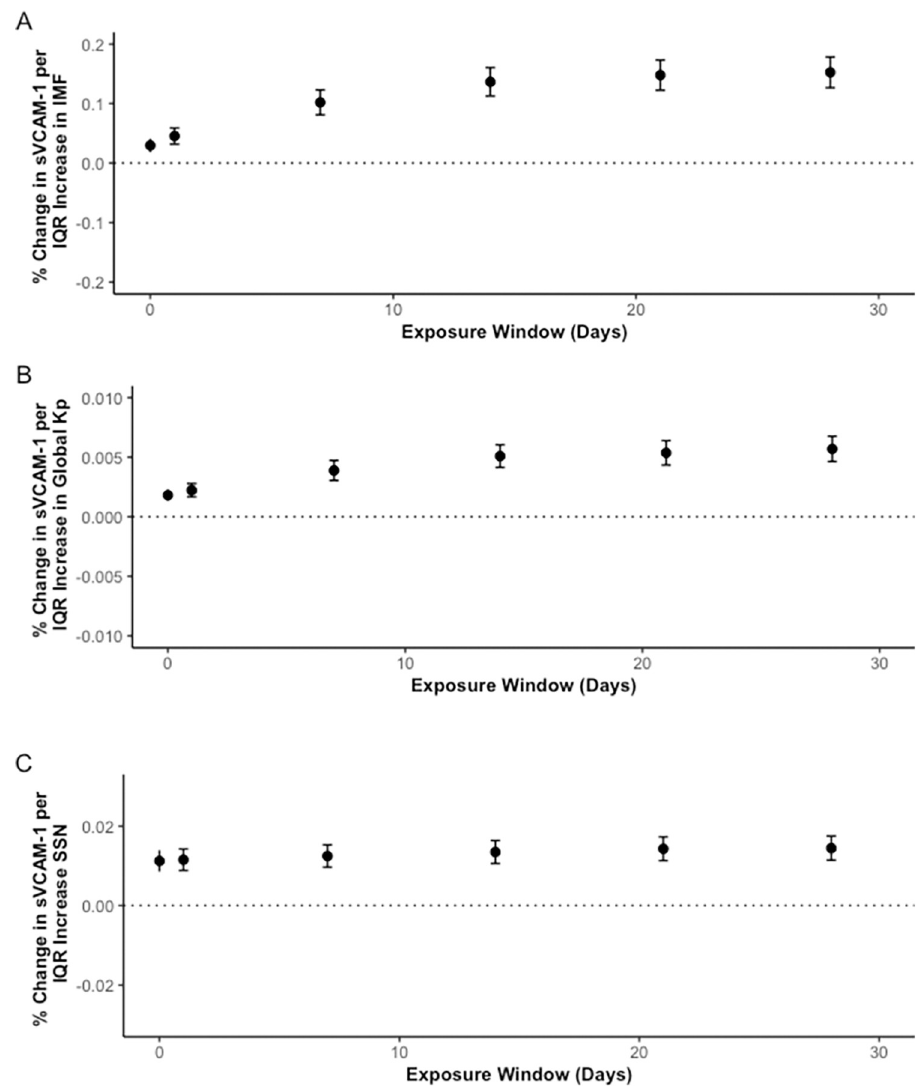
Fig 2. Percent change in sVCAM-1 concentrations per IQR increase in IMF (A), K p index (B), and SSN (C) over 28 day moving averages. � y-axes have different